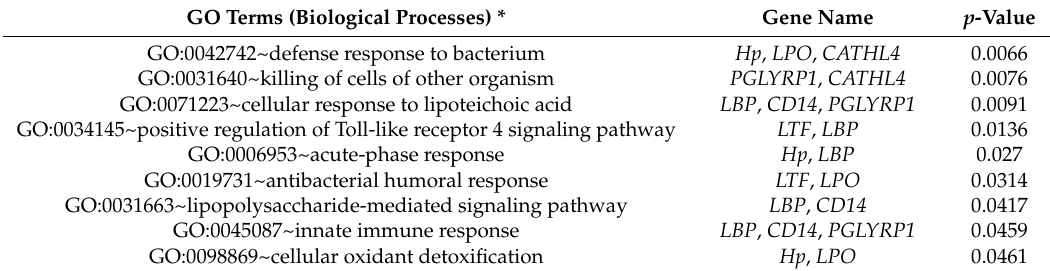
Table 2. Biological processes (BP) that were significantly enriched in differentially abundant proteins during S. aureus